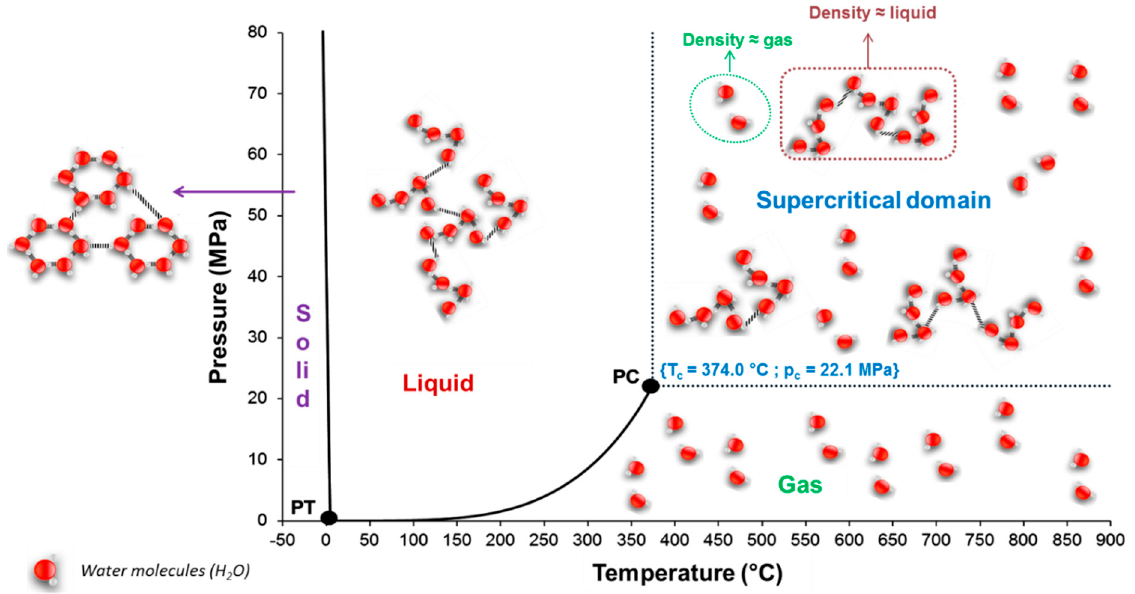
Figure 36. Pressure–temperature phase diagram of pure water. TP is the triple point (T TP = 0.01 °C, P PT = 612 Pa) and CP is the critical point (T CP = 374.1 °C, P CP = 22.1 MPa). Water molecules are draw schematically (planar view) for each state—solid, liquid and gas—and in the case of the supercritical conditions. Reprinted with permission from Reference [108]. Copyright 2010 Wiley.